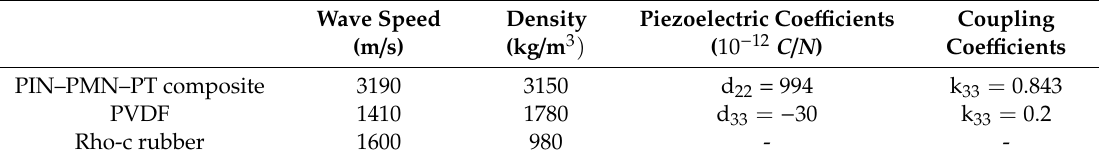
Table 1. Properties of the components of the proposed multilayer sensor.